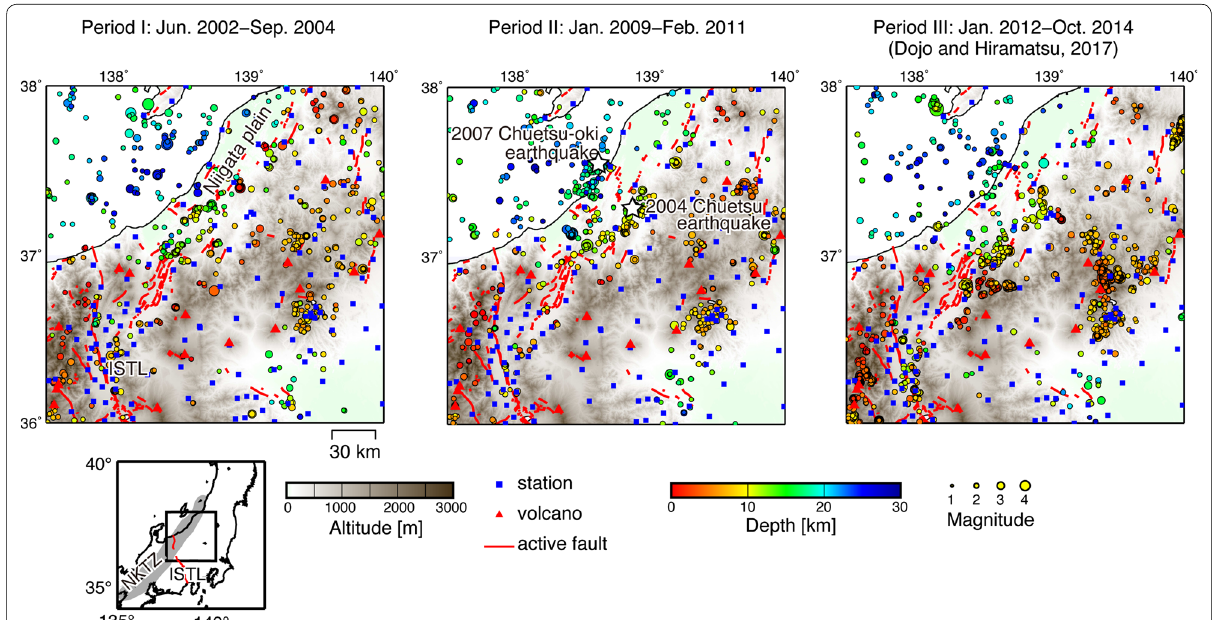
Fig. 1 Spatial distribution of epicenters (circles) and stations (blue squares) used in this study [left panel Period I, middle panel Period II, and right panel Period III (Dojo and Hiramatsu 2017)]. Stars in the middle panel are the epicenters of the 2004 Chuetsu earthquake and the 2007 Chuetsu-oki earthquake. Red lines and triangles, respectively, show Quaternary active faults and volcanoes. In the lower-left panel, the analyzed area is shown by a square, the Itoigawa–Shizuoka Tectonic Line (ISTL) by red lines, and the Niigata–Kobe Tectonic Zone (NKTZ) by a gray